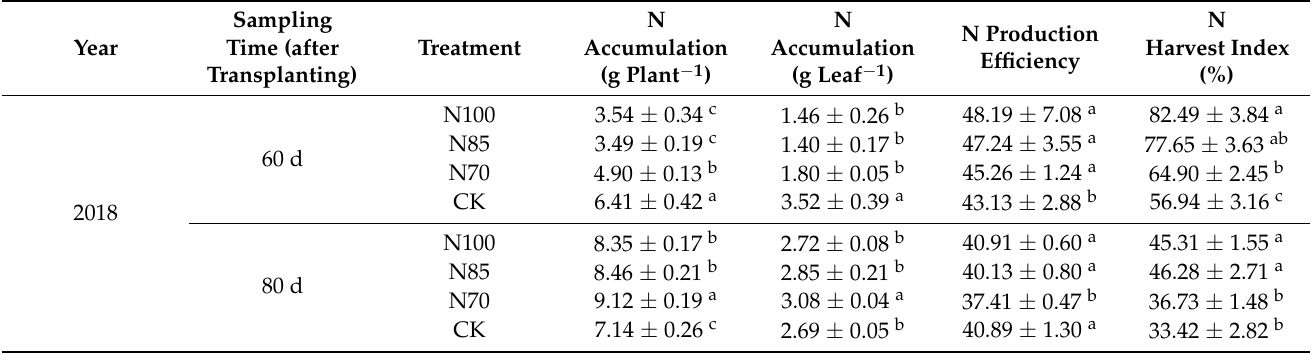
Table 6. Effect of reduced nitrogen application on nitrogen uptake in roasted